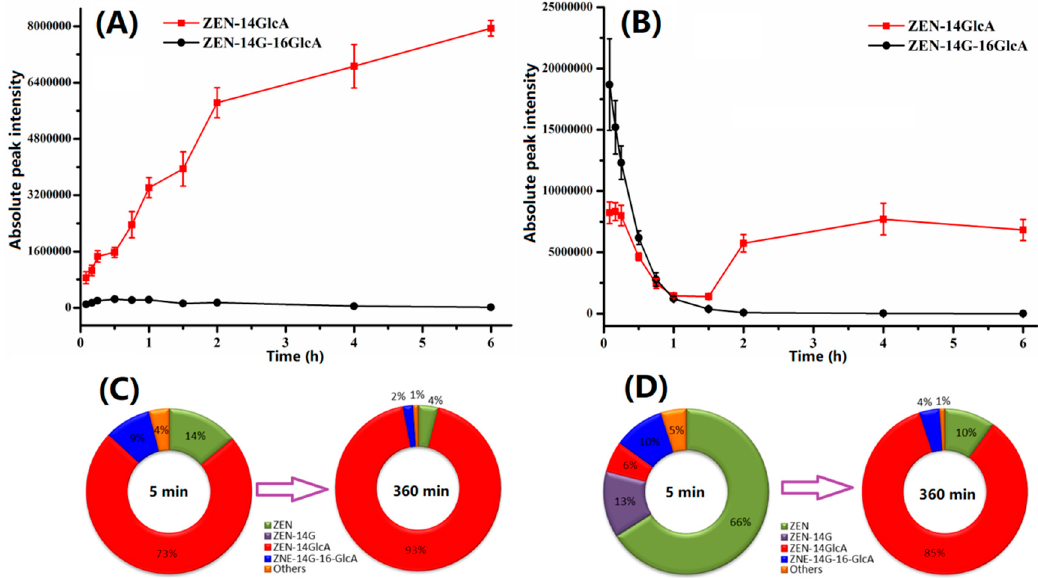
Figure 4. ( A ) Profile of ZEN-14GlcA and ZEN-14G-16GlcA after oral administration of ZEN-14G. ZEN-14GlcA continued accumulating since the first time-point. ( B ) Profile of ZEN-14GlcA and ZEN-14G-16GlcA after intravenous injection of ZEN-14G. The fluctuation of ZEN-14GlcA was observed. ( C ) Dynamic profile of different components in plasma after oral administration. ZEN-14GlcA was dominant throughout the whole study. ( D ) Dynamic profile of different components in plasma following intravenous administration. ZEN-14G was swiftly deglycosylated into ZEN after intravenous injection and then bound with glucuronic acid, generating ZEN-14GlcA.